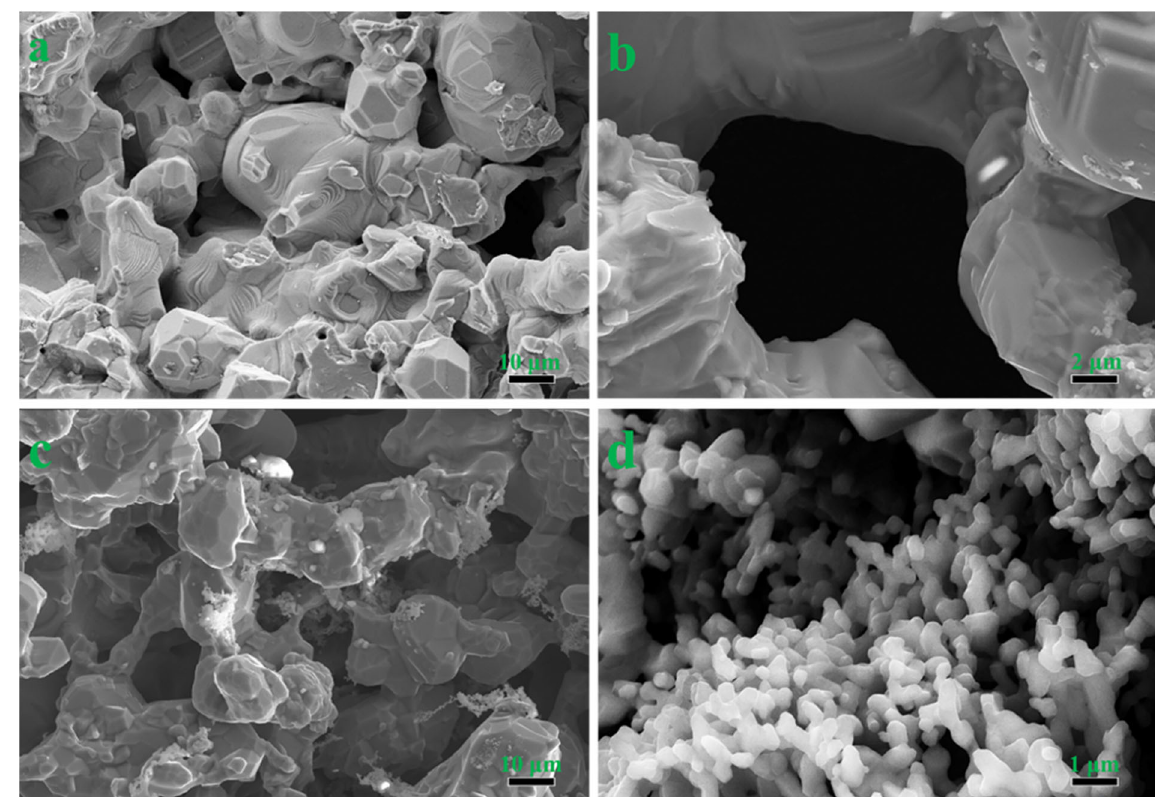
Fig. 6 FESEM image of porous sample. Ti-48Al-6Nb porous alloy: a surface; b cross-sectional; PCMM: c surface; d cross-sectional.